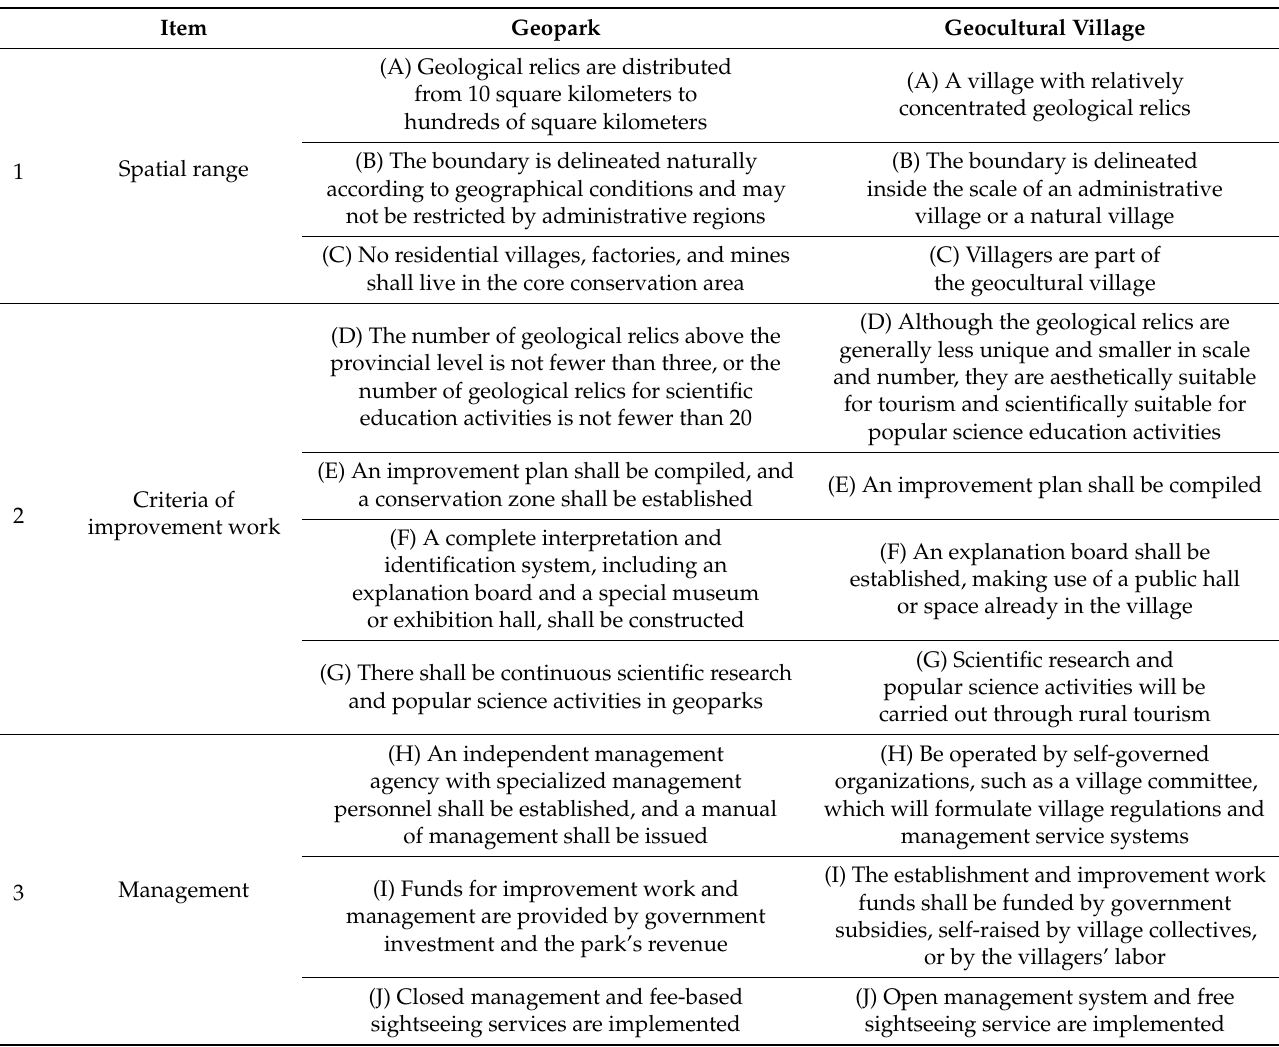
Table 4. The differences between geoparks and geocultural villages in